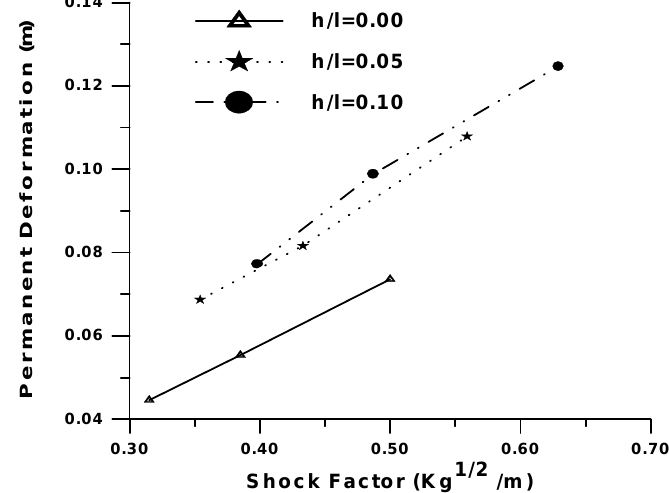
Fig. 7. Shock factor Vs permanent deformation (Experimental).